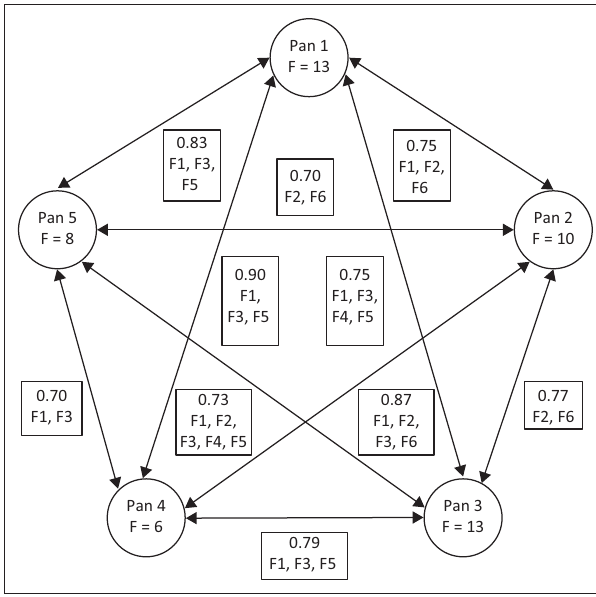
FIGURE 8: Pair distances between the pans indicating dissimilarity based on macro-invertebrate family richness (F), where F1 = Notonoctidae, F2 = Chironomidae, F3 = Podonidae (water flea), F4 = Gerridae, F5 = Branchinectidae ( Brachipodopsis wolfi ) and F6 = Branchinectidae ( Leptestheria rubidgei ).